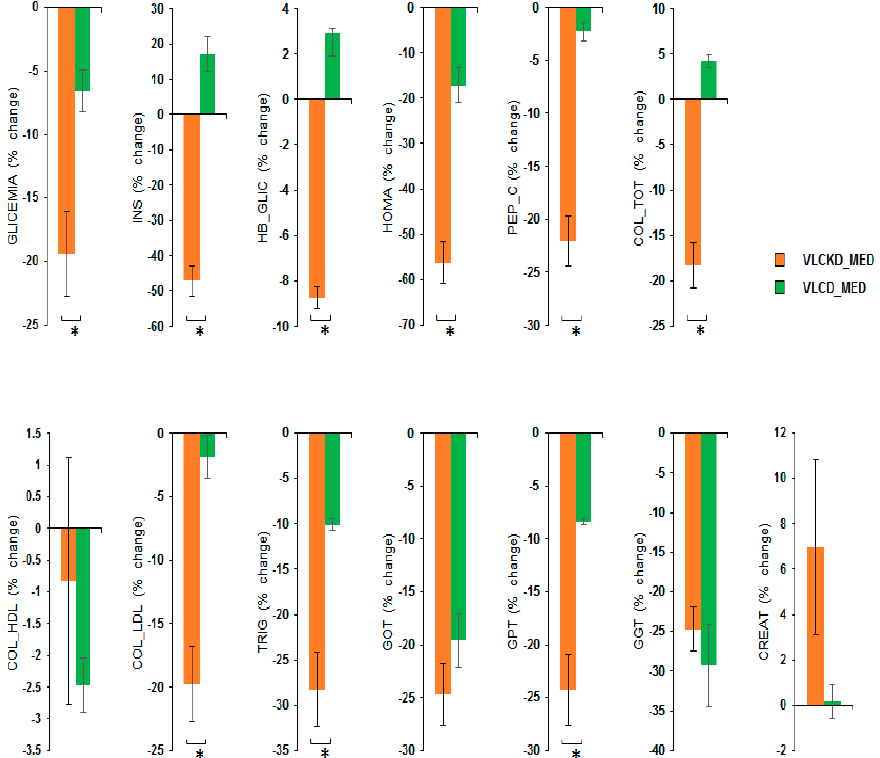
Figure 3. Percentage change in the blood chemistry variables after VLCKD_MED and VLCD_MED diet. The histogram depicts the % change (post-pre diet) in the level of: GLYCEMIA, i.e., blood glucose